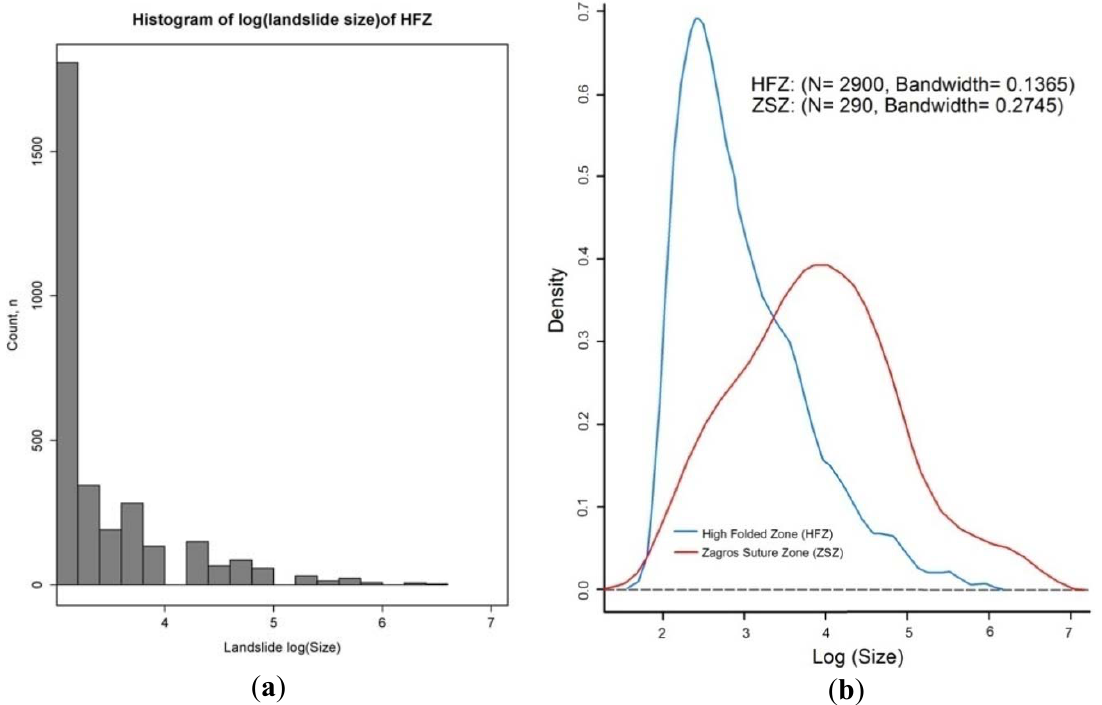
Figure 10. Statistic plots, ( a ) Histograms showing the number (count) and size of landslides in logarithmic coordinates; ( b ) Probability density distribution showing 290 landslides within the Zagros Suture Zone (ZSZ), and 2,900 landslides within the High Folded Zone